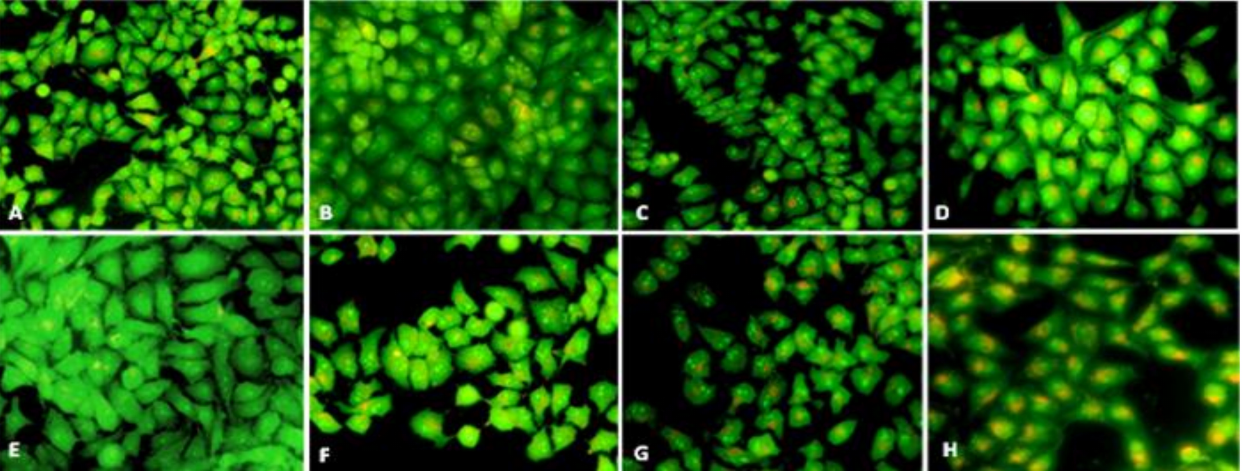
Figure 11. Detection of autophagy triggered by SMAgNPs in HepG2 cells after the treatment using AVOs staining with AO. Representative fluorescent microscopic images of control ( A , E ), 20 µ g/mL ( B , F ), 40 µ g/mL ( C , G ), and 60 µ g/mL ( D , H ) after 12 h ( A – D ) and 24 h ( E – H ), respectively. (Magnification 40 ×